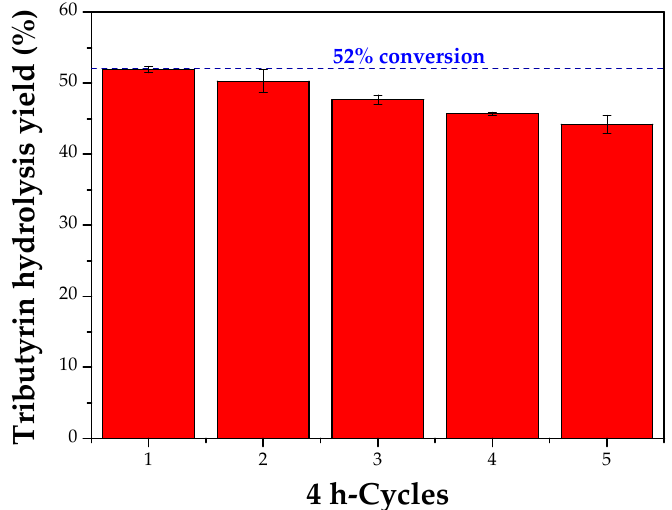
Figure 13. Reuse assay (4 h-batches) of the pm-SP-CLEA in the hydrolysis of tributyrin (74.22 mM) at 37 °C and pH 7.5 stirred at 500 rpm. Reaction medium: 6 mL sodium phosphate buffer (100 mM, pH 7.5), 16.5 mL distilled water, 0.5 mL tributyrin, and 70 TBU/g tributyrin.